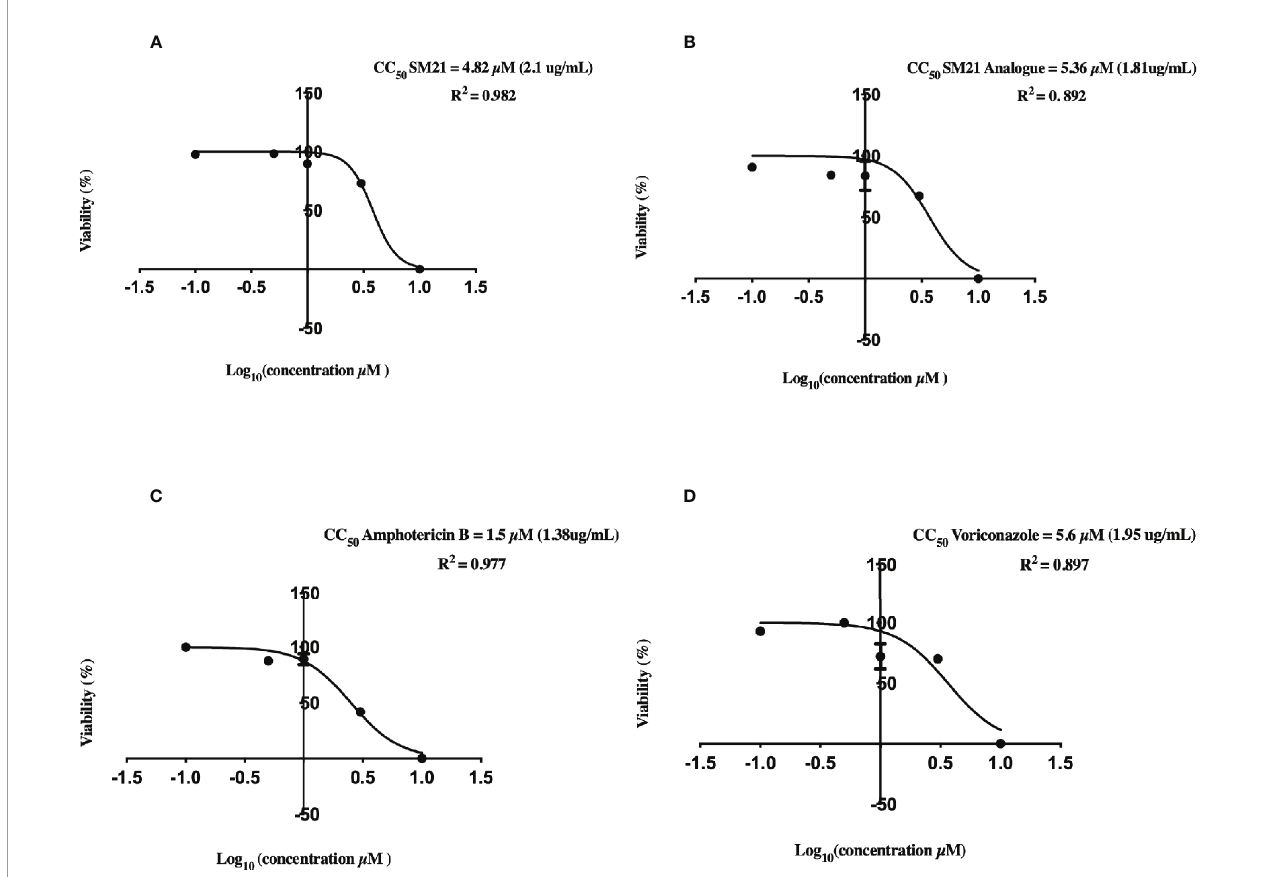
FIGURE 2 | Cytotoxicity of each drug on HK-2 cells determined by quantitative CellTiter-Glo® of ATP Luminescent Cell Viability Assay. CC 50 of Logarithm curves (A) SM21, (B) SM21 Analogue, (C) Amphotericin B, and (D) Voriconazole. The graphs were plotted based on logarithm of drug dosage and the CC 50 was calculated by probit regression method using Prism 8. SM21 and its analogue showed lesser cytotoxicity and potency to induce proximal tubular damage in HK-2 compared to AmB (4.82, 5.36, and 1.5 m M; respectively). HK-2, immortalized human kidney proximal tubule epithelial